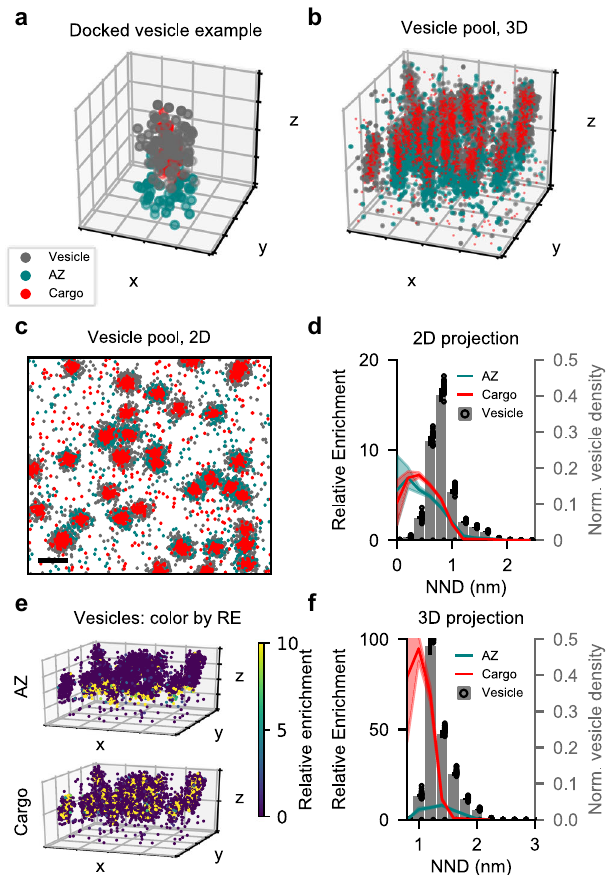
Fig.4|ValidationofRE-scoringin3D.a Simulationofasingledockedvesiclewith three molecular species: a vesicle membrane-bound, a SNARE-like and a lumenal. Grid is50by 50nm. b Representative simulation of twentyvesicles. Halfdockedat the membrane and associated with SNARE-like molecules, and half in the intra- cellularspacewithoutSNAREassociation.Gridis200by200nm. c 2Dprojectionof representative simulation in ( b ). Scale bar is 100nm. d Vesicle Voronoï regions binned by nearest neighbour distance in 2D, with mean RE value of each bin for both AZ and cargo as line plot. Shaded area indicates S.E.M., n =20. Scale bar is 100nm. e Simulated vesicle localizations from ( b ) color-coded for their relative enrichmentofeitherSNARE(top)forlumenal(bottom)localizations.Gridis200by 200nm. f VesicleVoronoïregionsbinnedbynearestneighbourdistancein3D,with meanREvalueofeachbinforbothAZandcargoaslineplot.Shadedareaindicates S.E.M., n